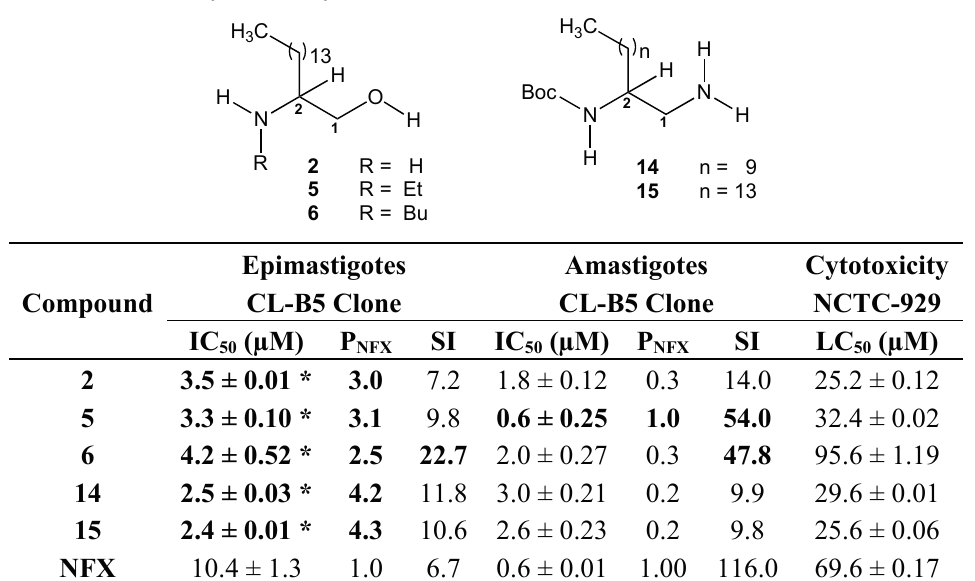
Table 3. In vitro activity against epimastigotes and amastigotes of Trypanosoma cruzi CL-B5 clone and NCTC-929 cytotoxicity values of selected aminoalcohol and diamine